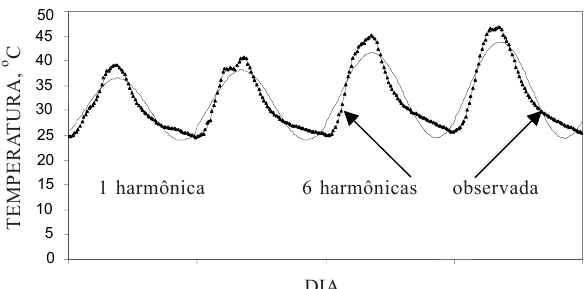
Figura 3. Ajustamento da temperatura de superfície por séries de Fourier a uma e seis harmônicas.